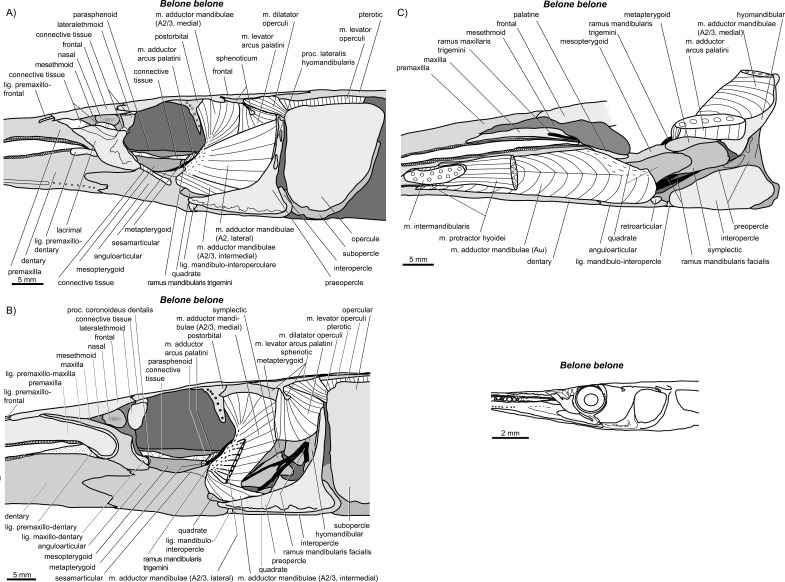
Belone belone.(A–C) Manual dissections. Compare to Fig. 2H.